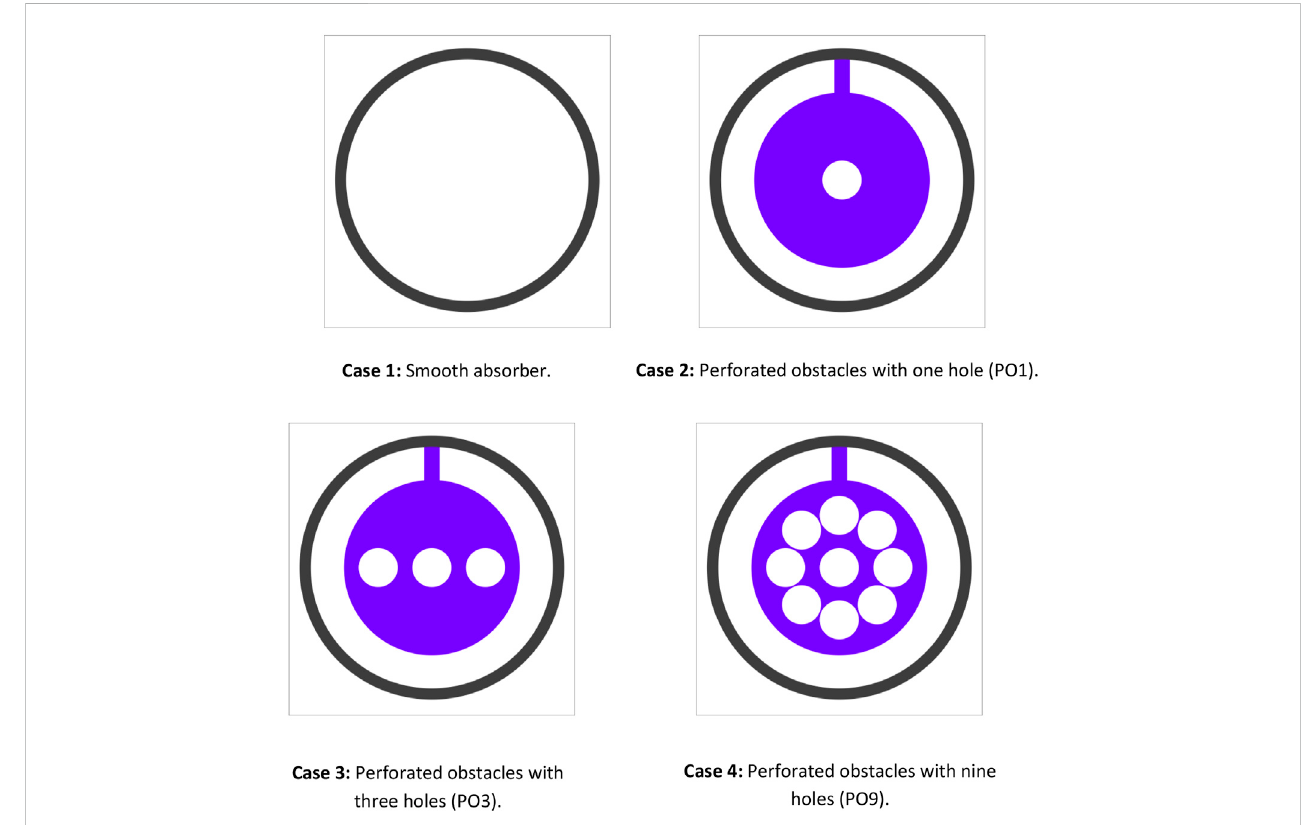
FIGURE 3 Cross-section of the receiver tube with perforated obstacles and smooth